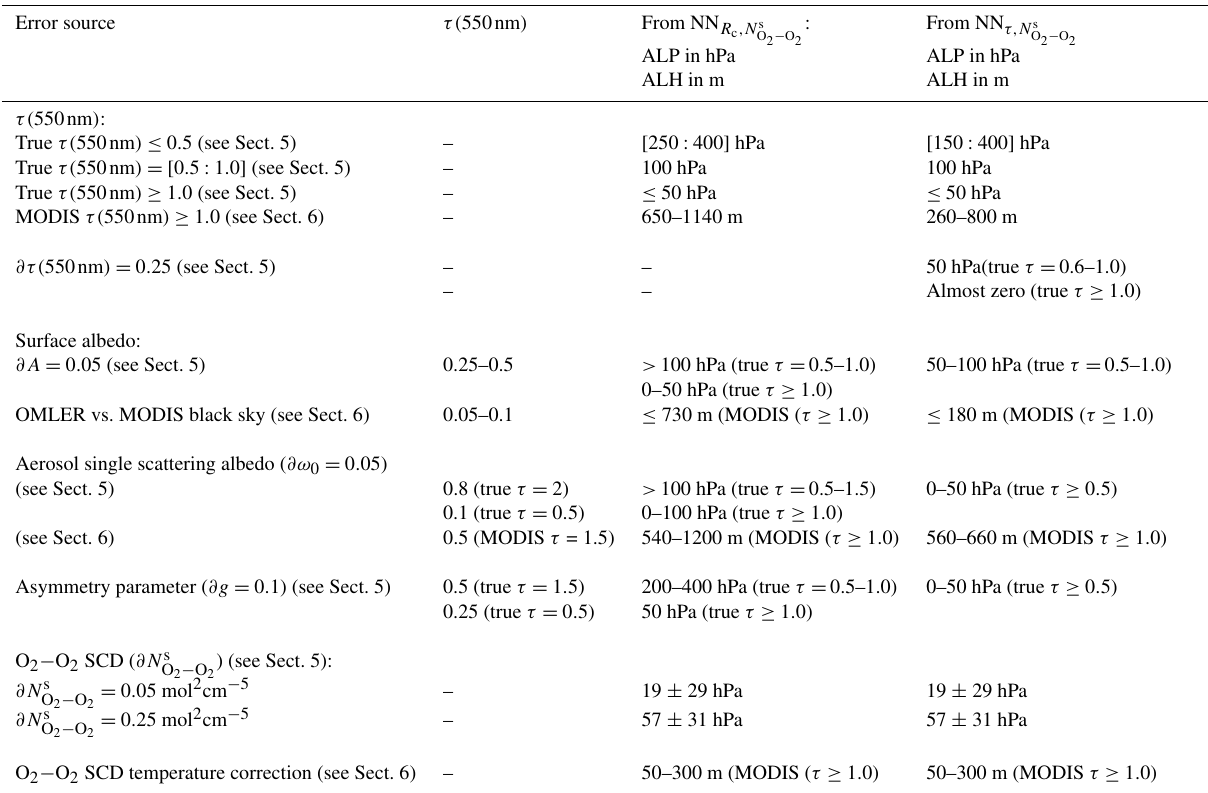
Table 2. Summary of OMI τ( 550nm ) and ALP retrieval error sources (either from NN R MODIS τ( 550nm ) ) and budget as evaluated by the sensitivity analyses on synthetic data set (see Sect. 5) or on 3-year (2005–2007) observa- tion measurements over north-east Asia (see Sect.